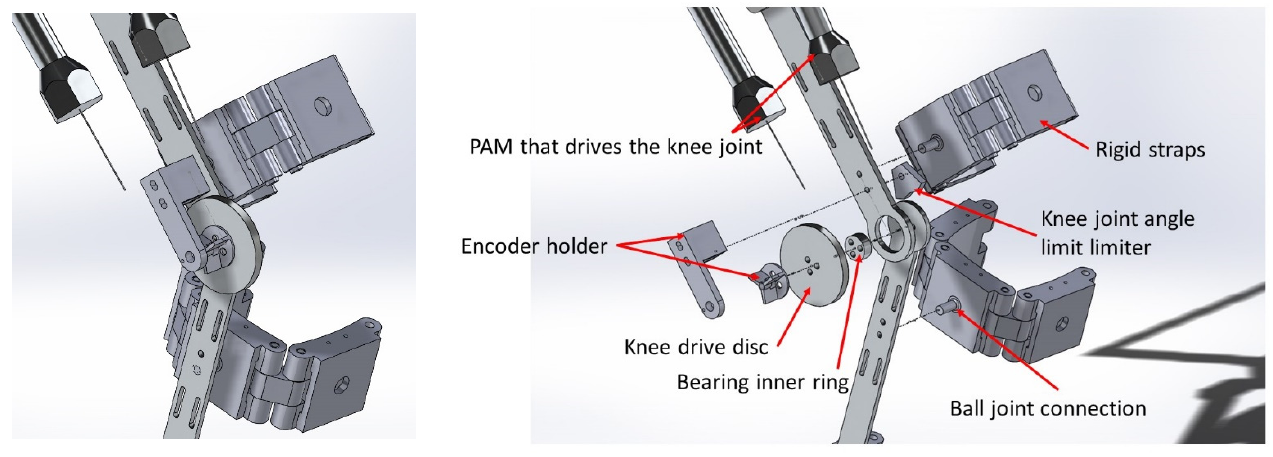
Figure 3. Knee joint exoskeleton design.